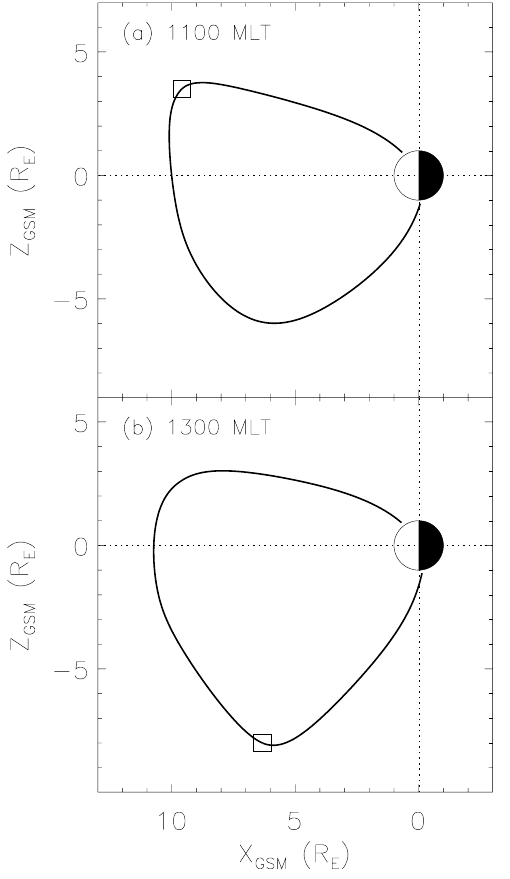
Fig. 7. Model representation of the last closed field line during this interval, in GSM x-z coordinates at ( a ) 11:00MLT, and ( b ) 13:00MLT. The square symbols represent the locations of the es- timated anti-parallel reconnection